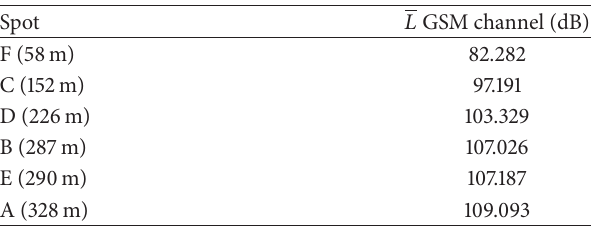
Table 2: Propagation losses of the H-O model for the measurement spots in Figure